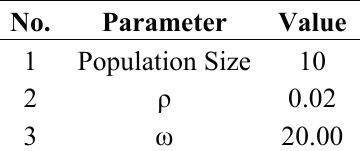
Table 6. The parameters of Ant Colony Optimization (ACO).